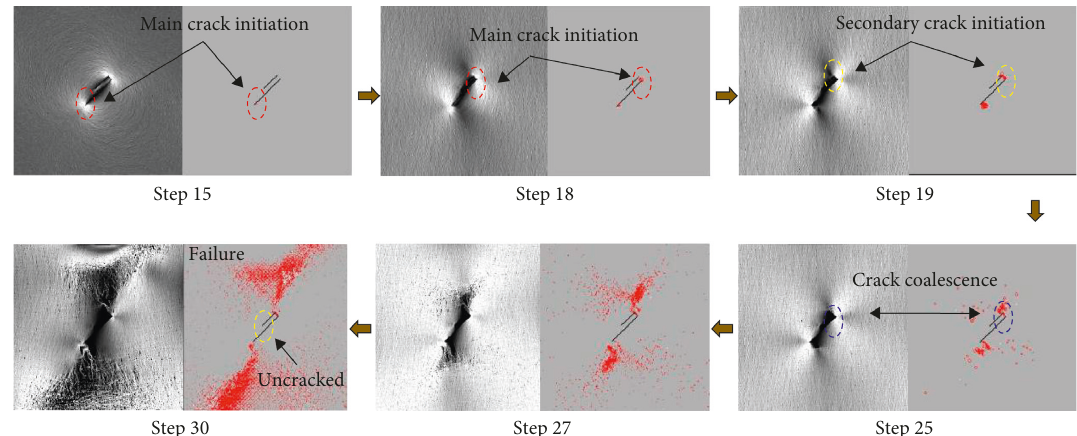
Figure 21: Crack initiation and propagation process in Model 1.